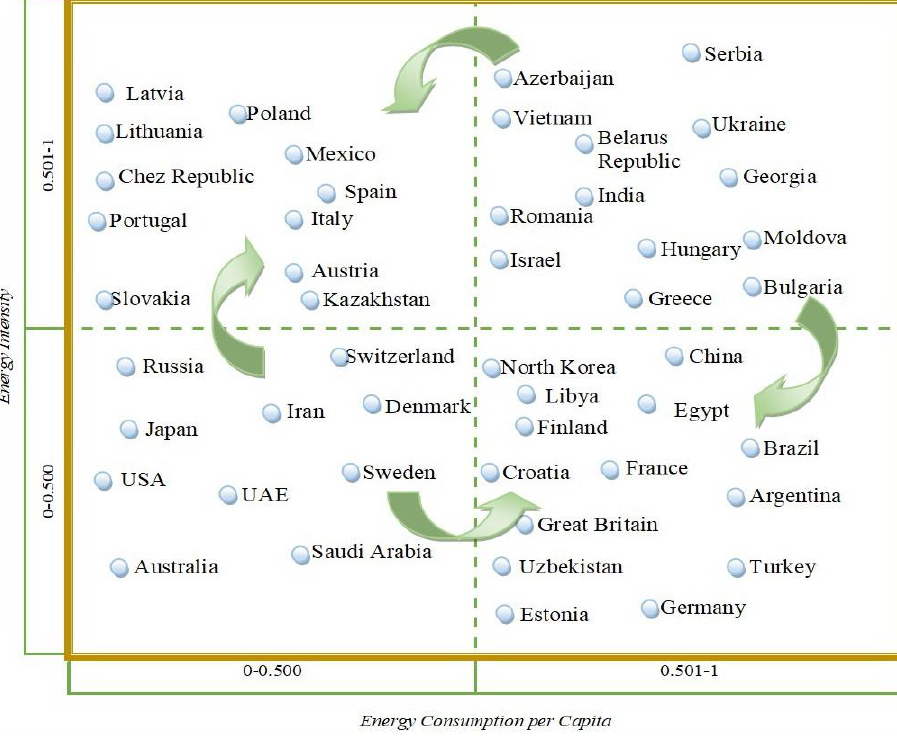
Figure 5. Energy dependence matrix classifying countries into four quadrants based on the integrative analysis of multiple indicators. Source: developed by the authors . analysis of multiple indicators. Source: developed by the authors.